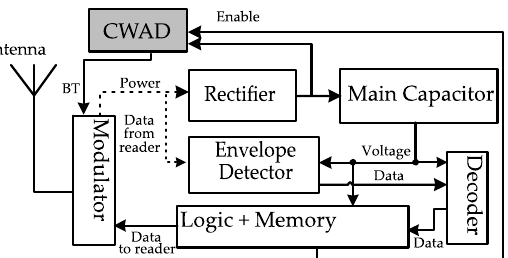
Figure 1. CWAD circuit after the rectifier in the general components of a passive RFID tag [10].